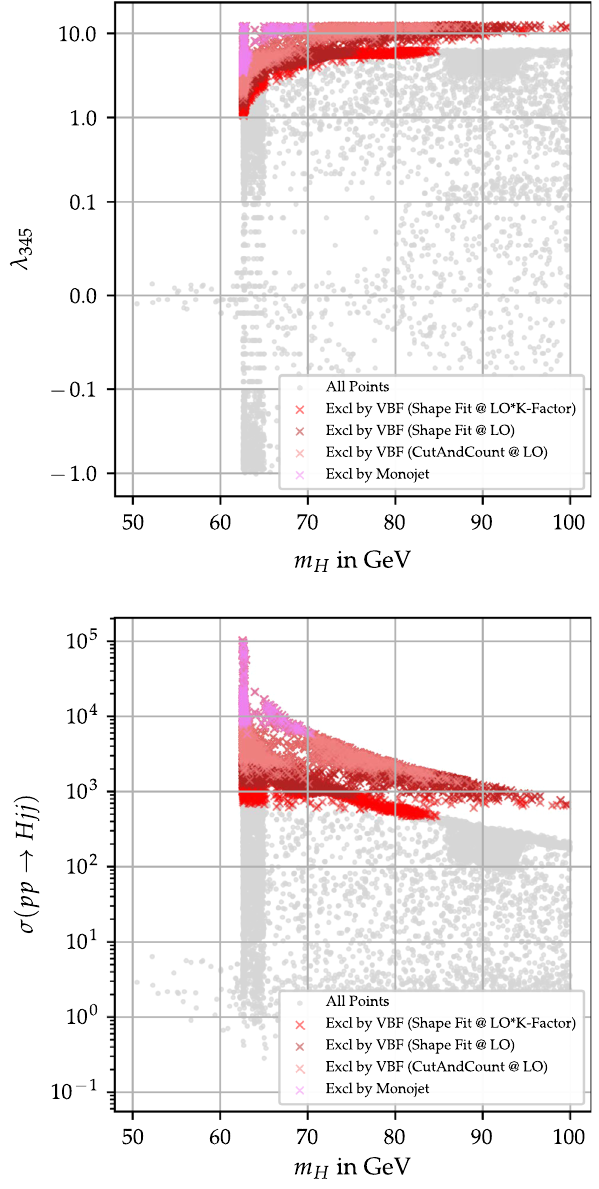
Fig. 2 Allowed and excluded points after consideration of VBF and monojet analysis but without dark matter relic density and direct detec- tion constraints. VBF results are shown using different categories, see in-text discussion. Top: Results in ( m H , λ 345 ) parameter plane. Bot- tom:Results in m H - σ plane where σ is the LHC VBF production cross section at 13 TeV including the partonic cuts given in Sect.